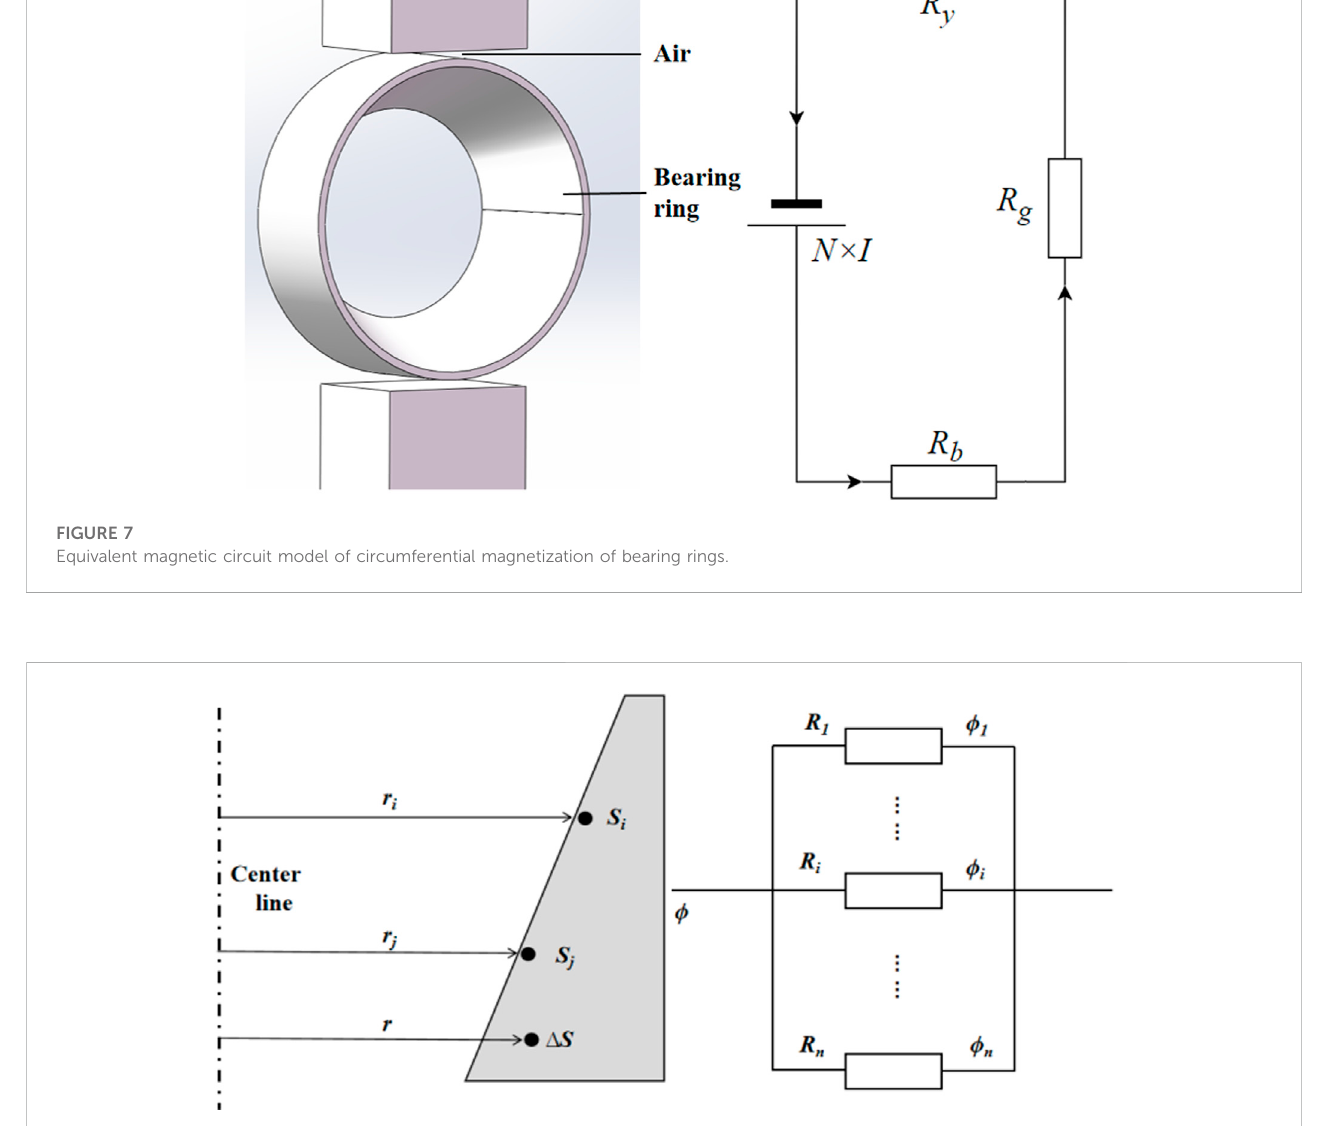
FIGURE 8 Sectional subdivision of bearing ring and corresponding